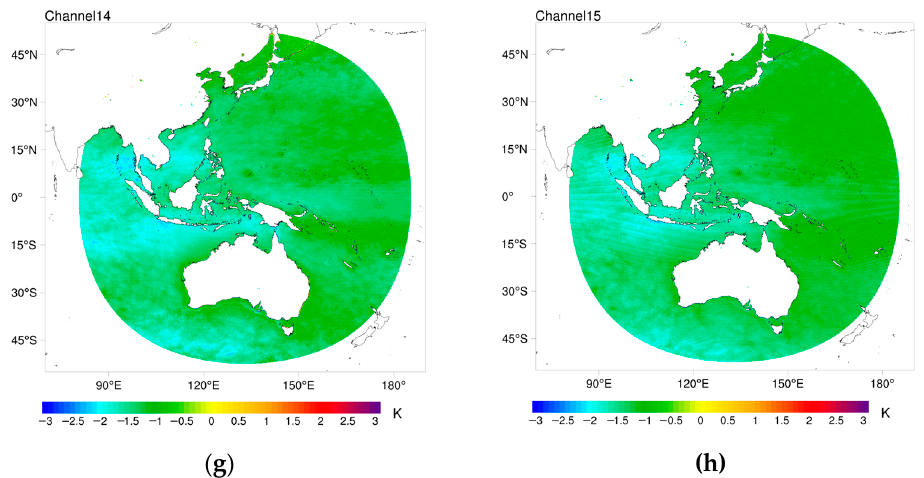
Figure 7. Spatial distributions of biases of Fengyun-4B/AGRI channels ( a – h ) 8–15 brightness tem- perature observations and RTTOV simulations over the ocean under clear-sky conditions and with satellite zenith angles less than 60° from June to November 2022.